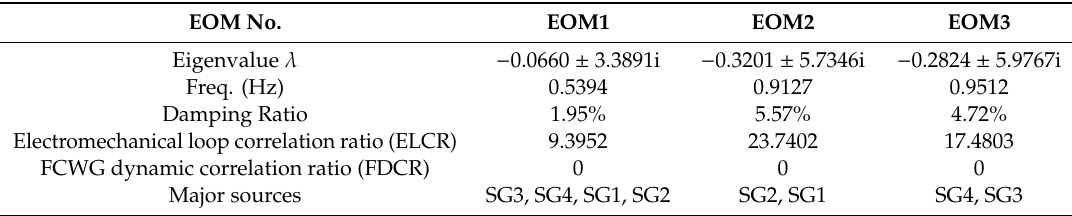
Table 1. Electromechanical oscillation modes (EOMs) of two-area power system (Pew = 0.0%). EOM No. EOM1 EOM2